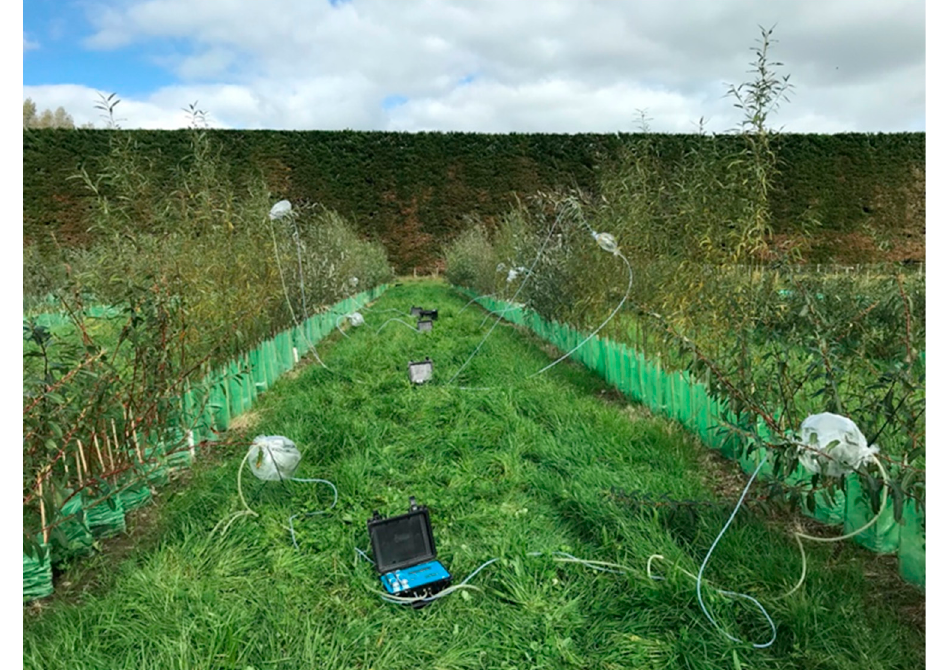
Figure 1. Volatile organic compound (VOC) sampling from willow foliage using a portable volatile assay system. Branches were enclosed in oven cooking bags, into which carbon-filtered air was circulated through a push-pull system.